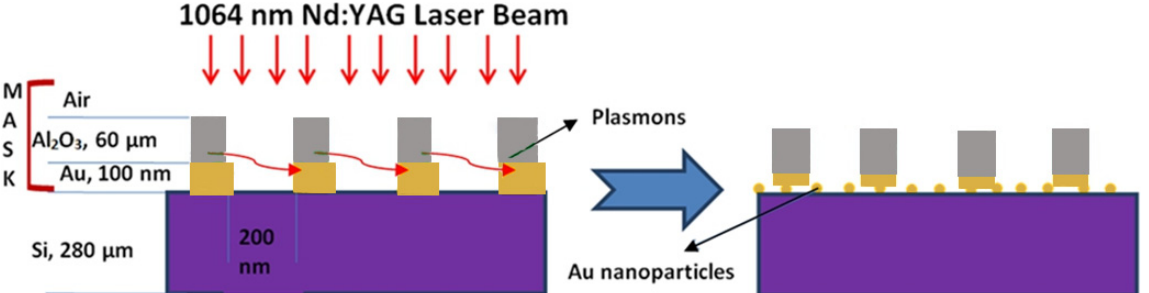
Figure 2. Schematic diagram of experimental excitation of surface plasmons and the resulting formation of